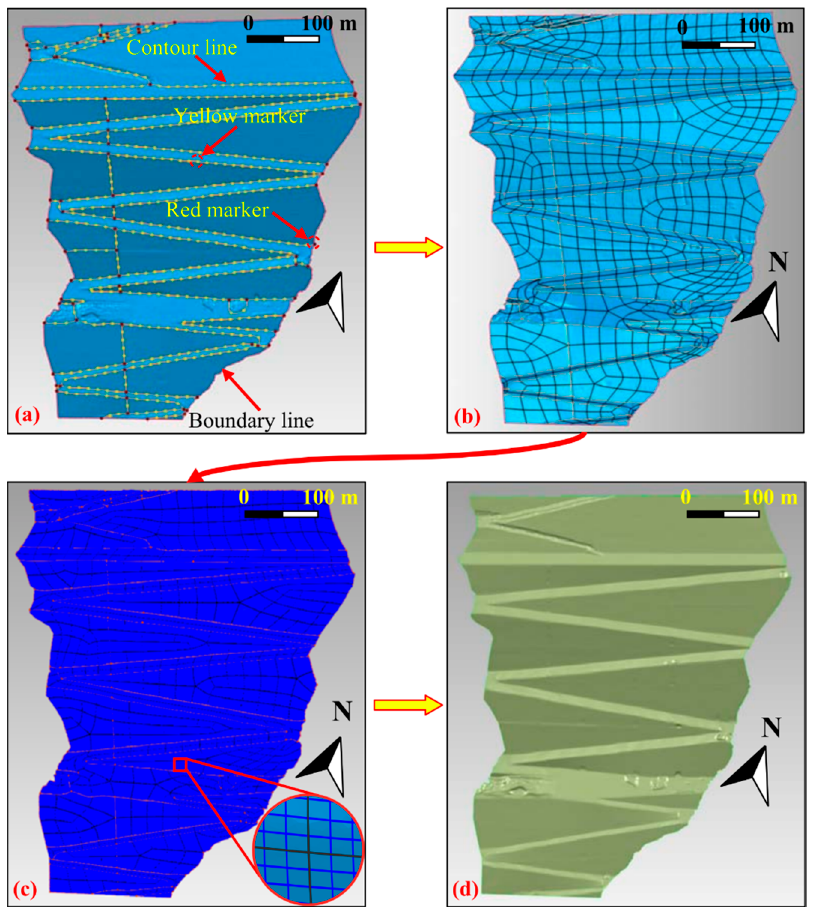
Figure 6. Non ‐ uniform rational B ‐ splines (NURBS) surface construction procedures: ( a ) panel Figure 6. Non-uniform rational B-splines (NURBS) surface construction procedures: ( a ) panel demarcation; demarcation; ( b ) surface patch insertion; ( c ) grid generation; ( d ) NURBS surface construction. ( b ) surface patch insertion; ( c ) grid generation; ( d ) NURBS surface